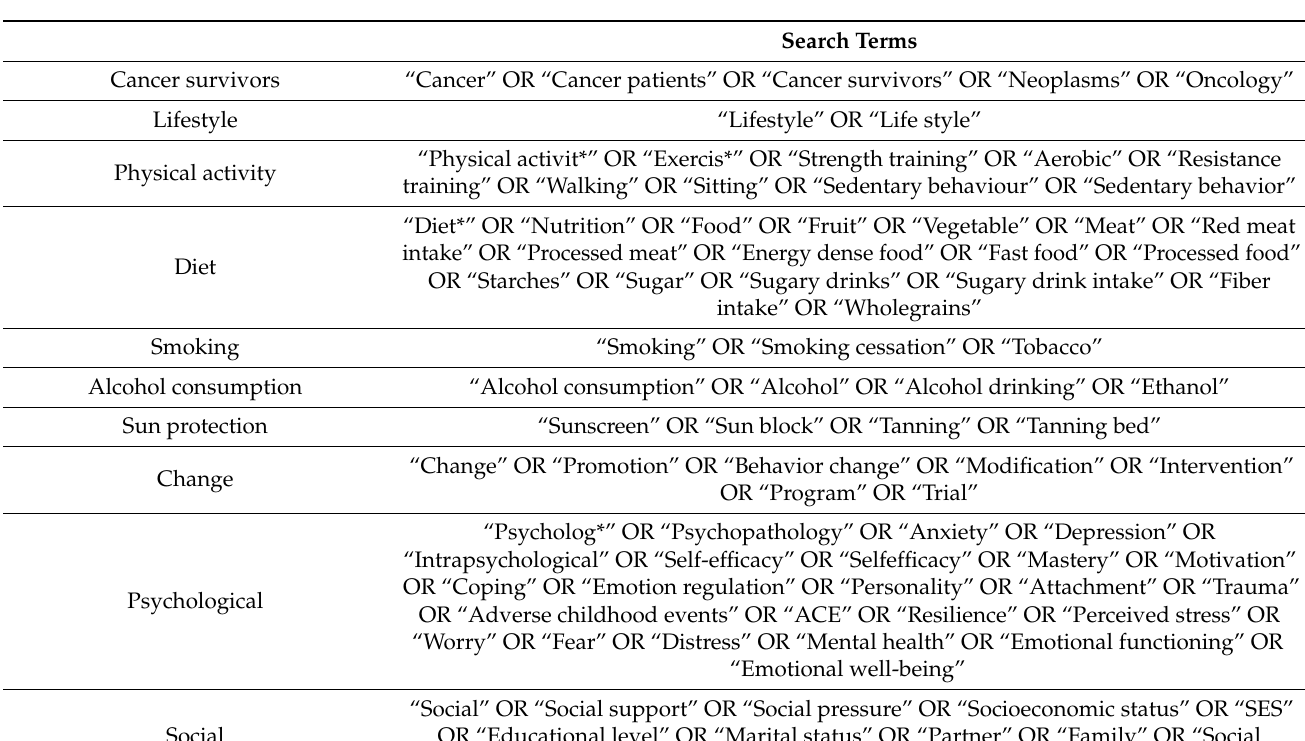
Table 1. Search terms used to select original research on psychosocial determinants of lifestyle changes in cancer